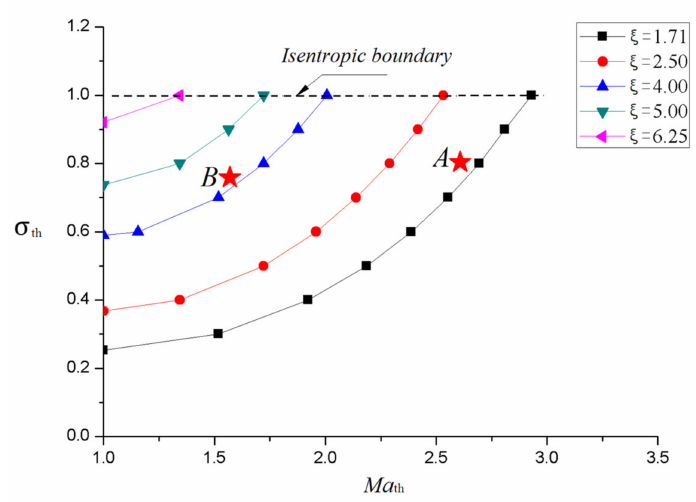
Figure 4. Change of Ma th and σ th with the compression ratio ξ ( Ma ∞ = 3.5). A : Characteristic point of the fixed-geometry inlet; B : Characteristic point of the adjustment